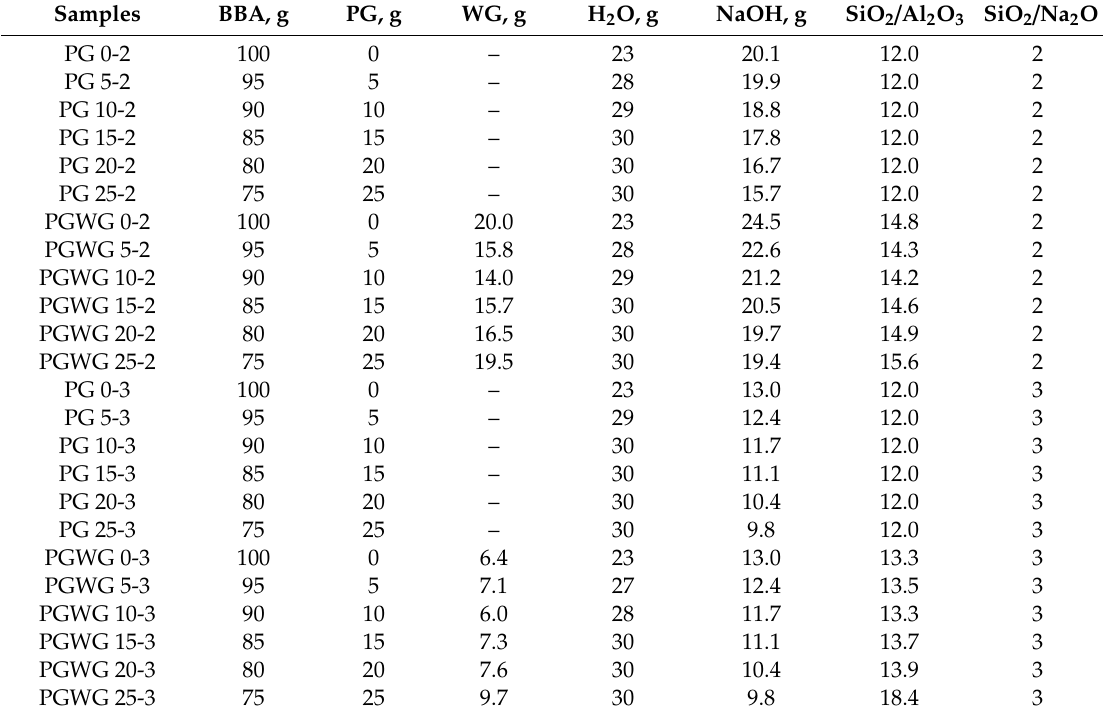
Table 2. The mixing composition of alkali activated biomass bottom ash pastes.